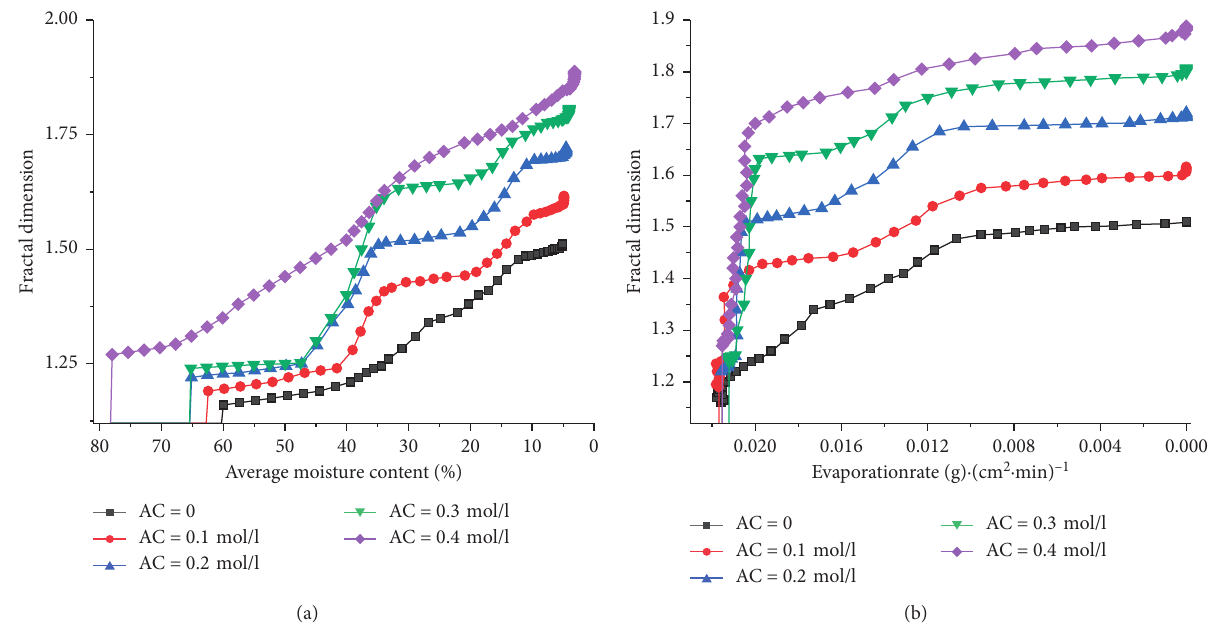
Figure 6: Fractal dimension variations of cracks in contaminated samples: (a) fractal dimension of cracks vs. average moisture content; (b) fractal dimension of cracks vs. evaporation rate.